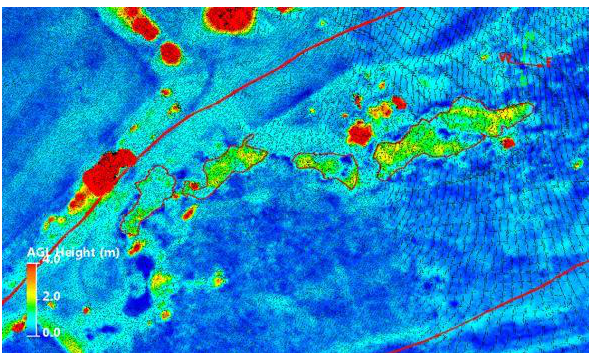
Figure 9. Above ground level (AGL) analysis of the surface roughness using the QTM AGL analyst tool.